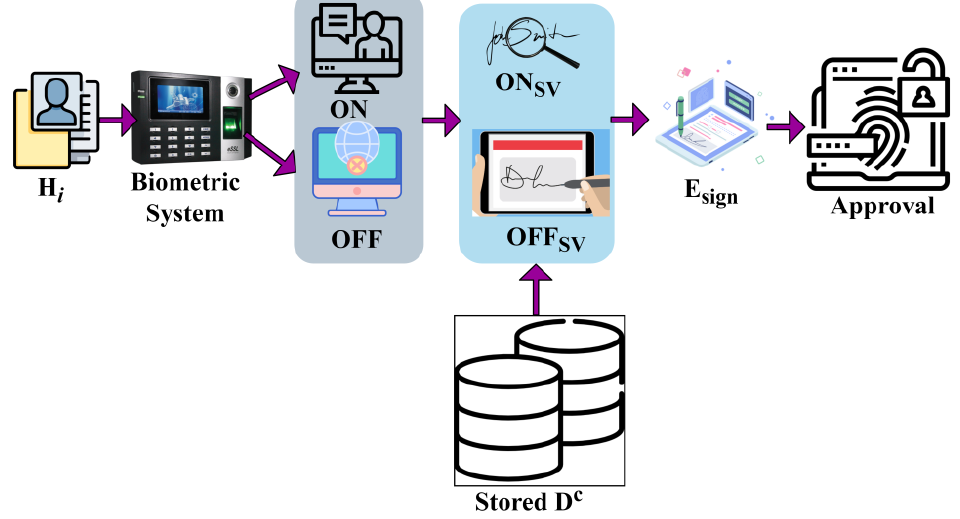
Figure 2. Signature verification and approval.